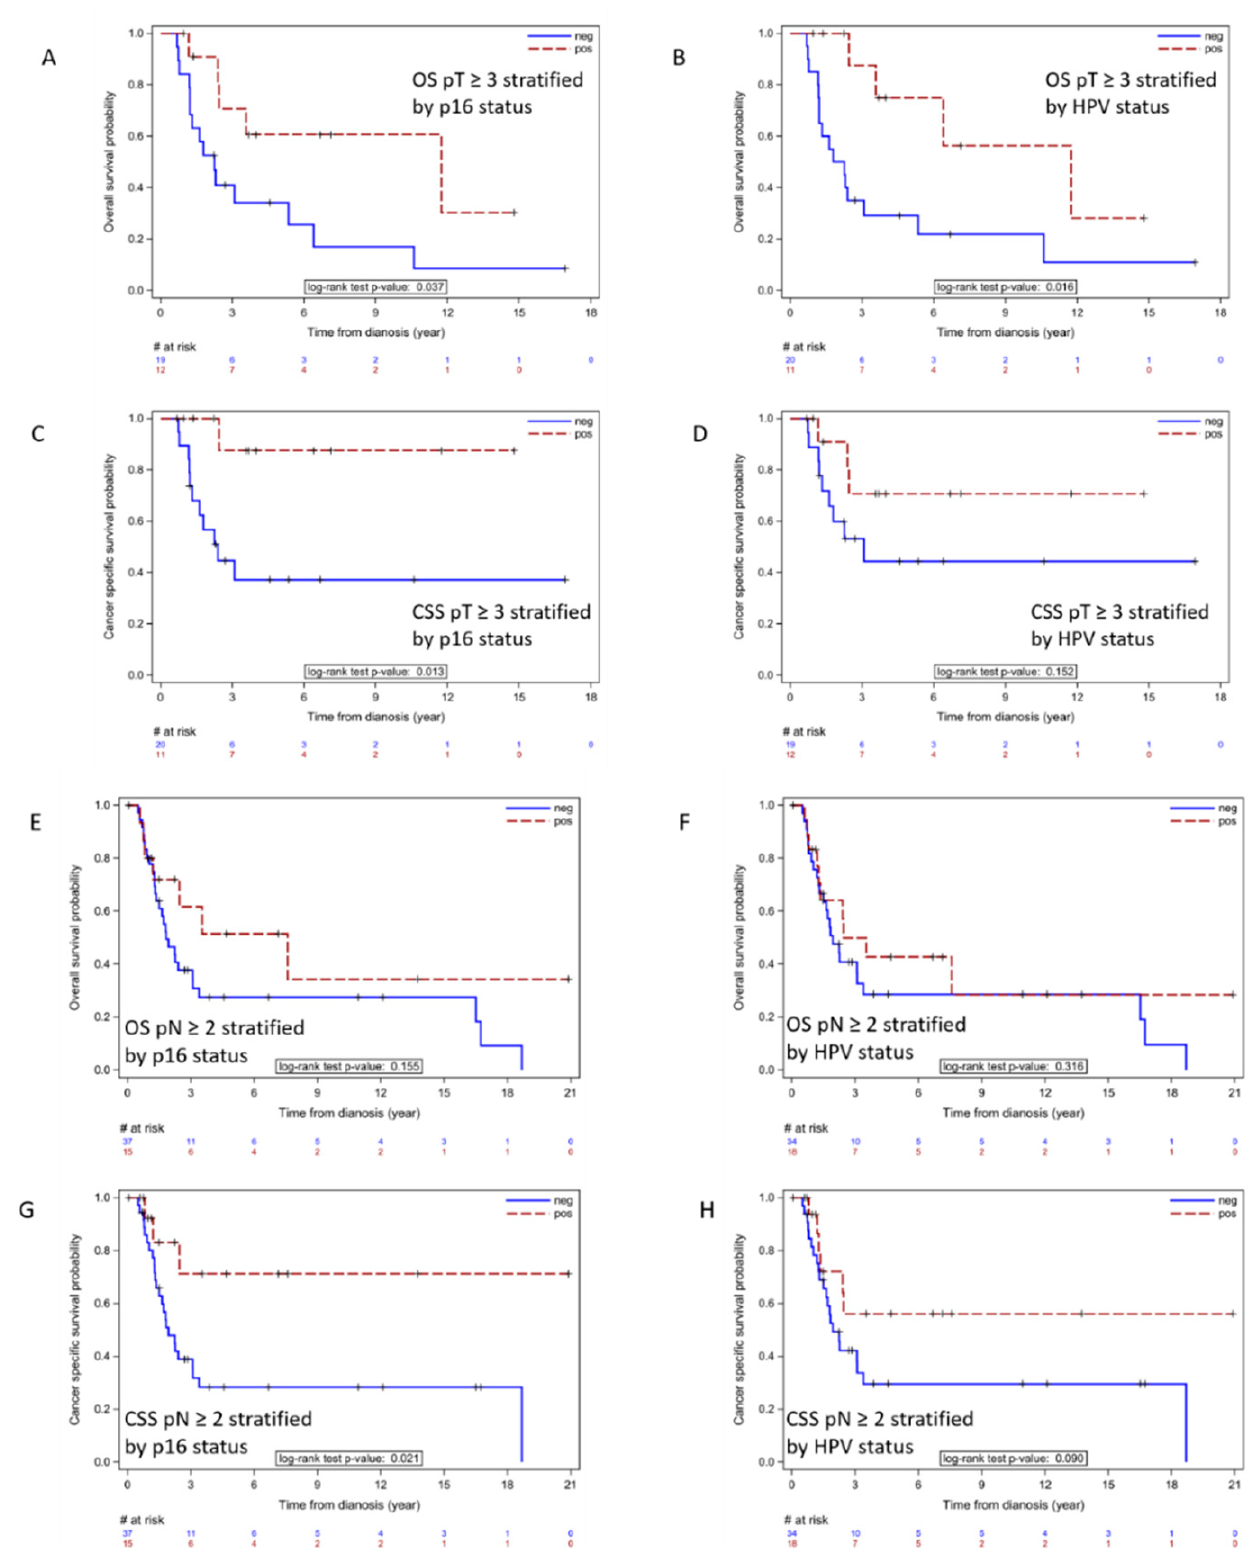
Figure 3. KM plots for CSS and OS for patients with pT stage of 3 and 4 stratified by p16 status ( A , C ) or by HPV status ( B , D ). Similar KM plots were generated for patients with 2 to 3 level of nodal involvement stratified by p16 ( E , G ) or by HPV status ( F , H ).